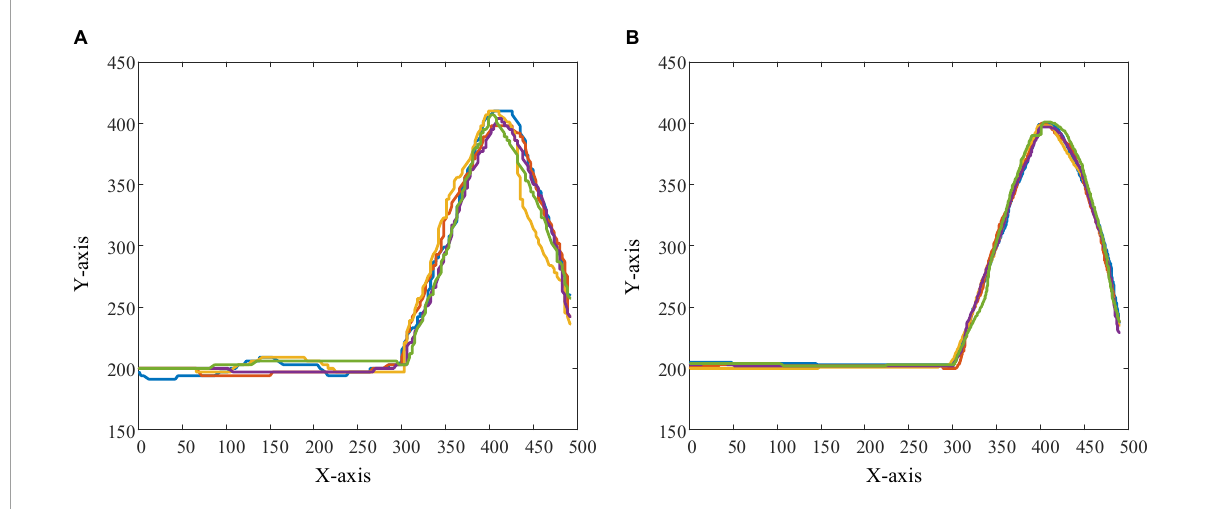
FIGURE16 The figure shows the trajectories of the mobile robot in the trajectory tracking task. (A) Robot trajectories in the control session. (B) Robot trajectories in the testing session.